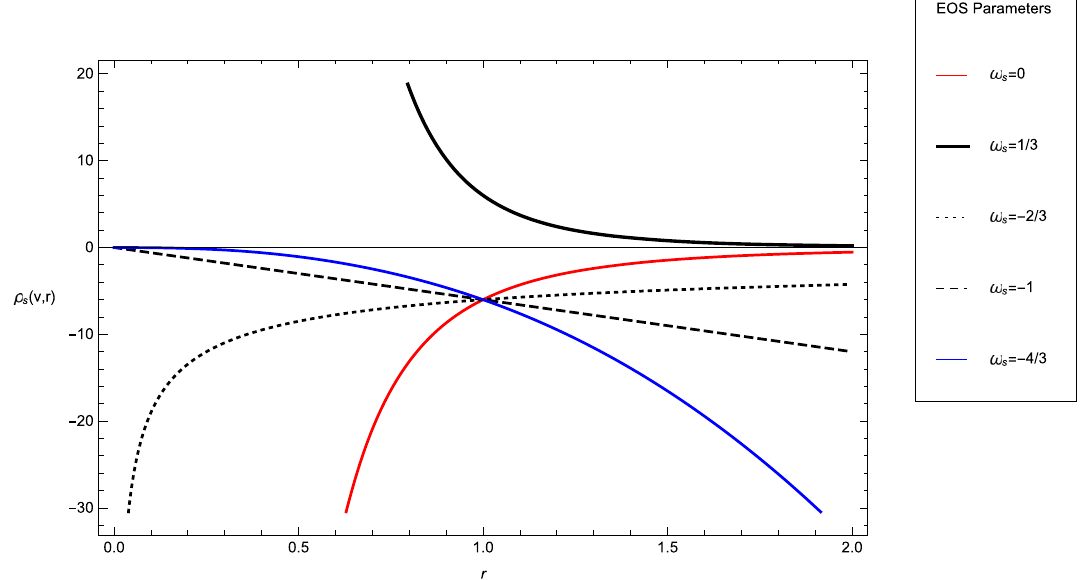
Fig. 4 Plot indicating the evolution of the energy density of the matter field with respect to r , for each of the constant parameters